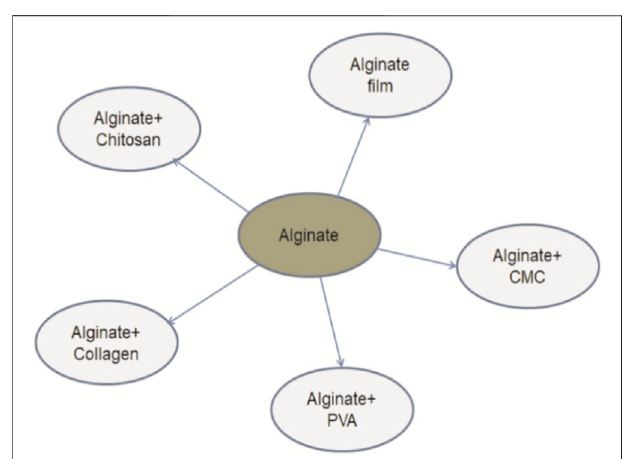
FIGURE 5 | Alginate modi fi cation incorporated with different biodegradable